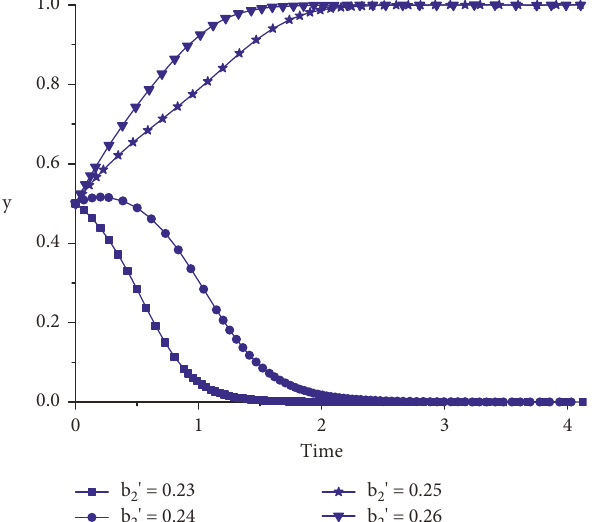
Figure 12: Impact of subjective spill coefficient k ′ on enterprise 2